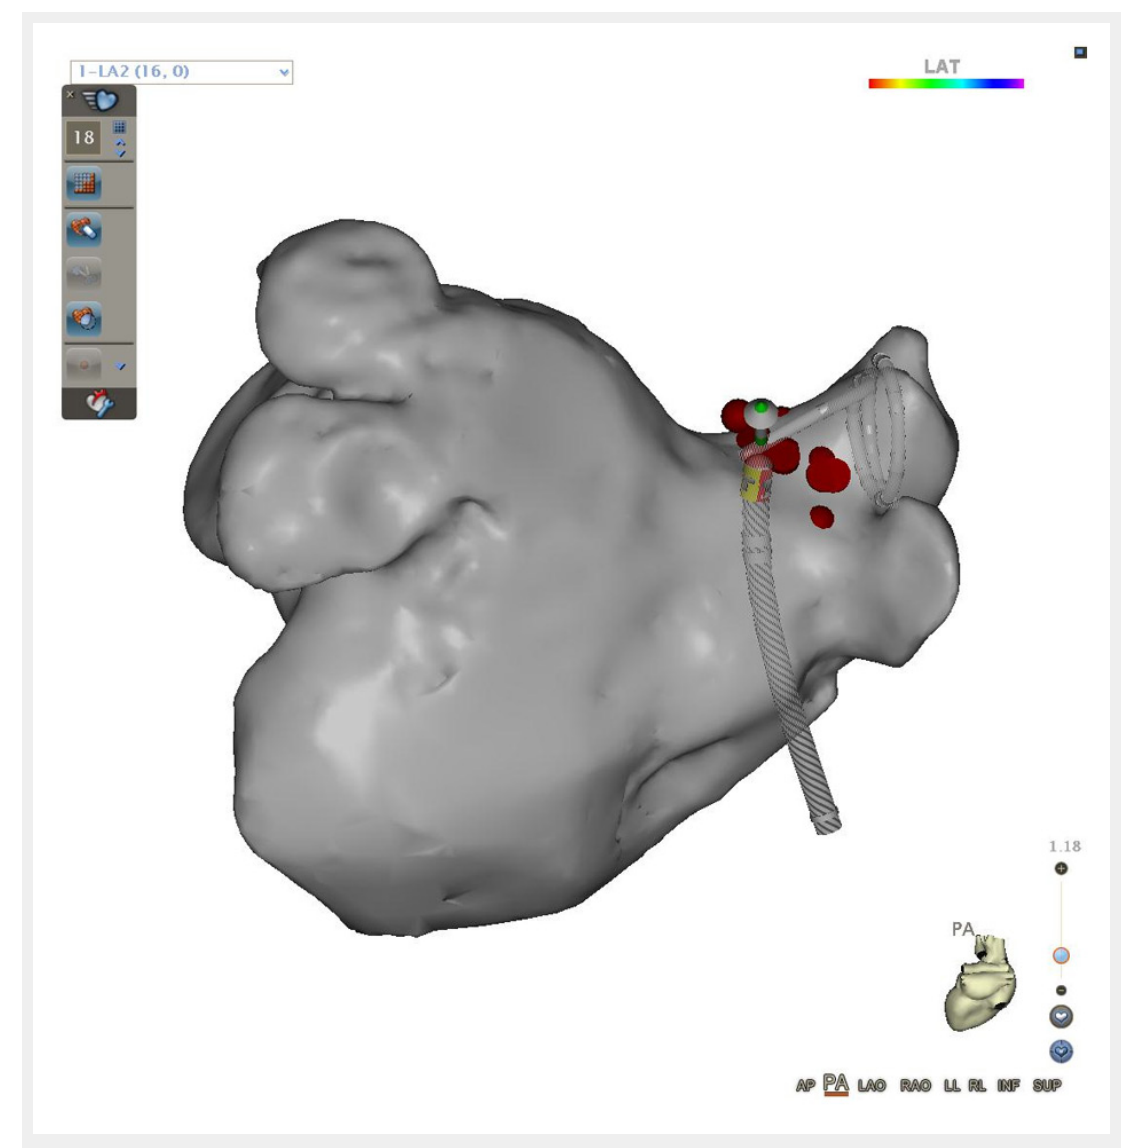
The aim of catheter ablation of atrial fibrillation is to electrically isolate the pulmonary veins. The 3D reconstruction of the left atrium with two right-sided and two left-sided pulmonary veins is shown in grey (posterior view). The 3D map of the left atrium is constructed at the beginning of the procedure to guide ablation, increase accuracy and decrease radiation exposure. In the featured case, radiofrequency ablation was started at the right superior pulmonary vein. The circular catheter within the right superior pulmonary vein is used to guide ablation and confirm isolation of the pulmonary vein at the end of the procedure. The ablation catheter is shown in a shaded grey with a red and yellow tip. The ablation points are shown in